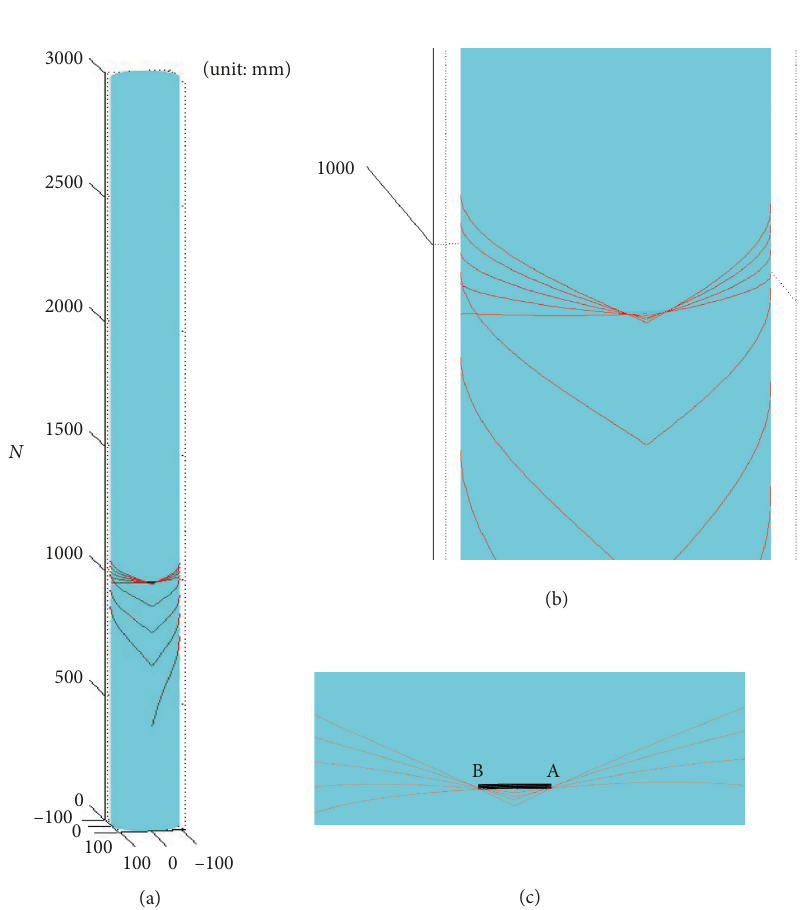
Figure 22: Single-defect imaging of pipe segment structure: (a) overall display, (b) partial display, and (c) detail